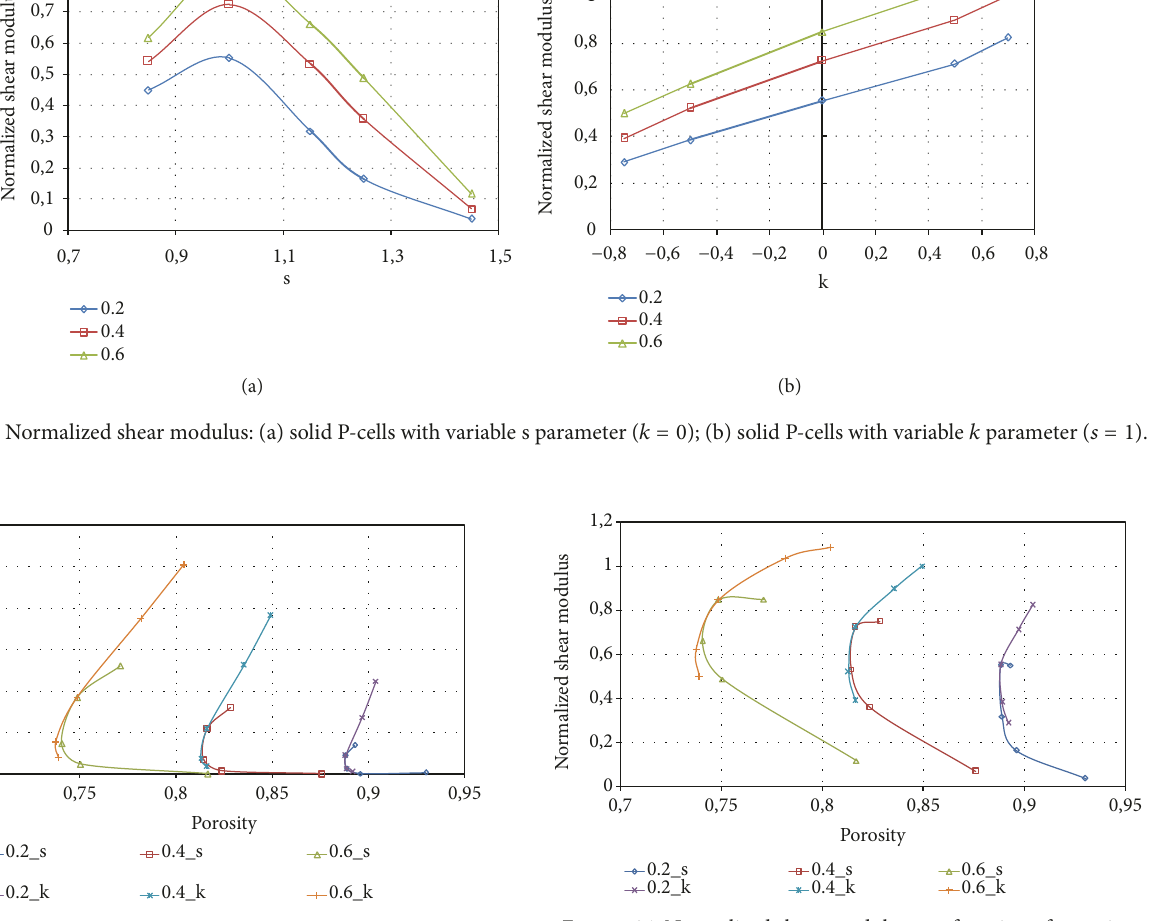
Figure 23: Normalized elastic modulus as a function of porosity. Figure 24: Normalized shear modulus as a function of